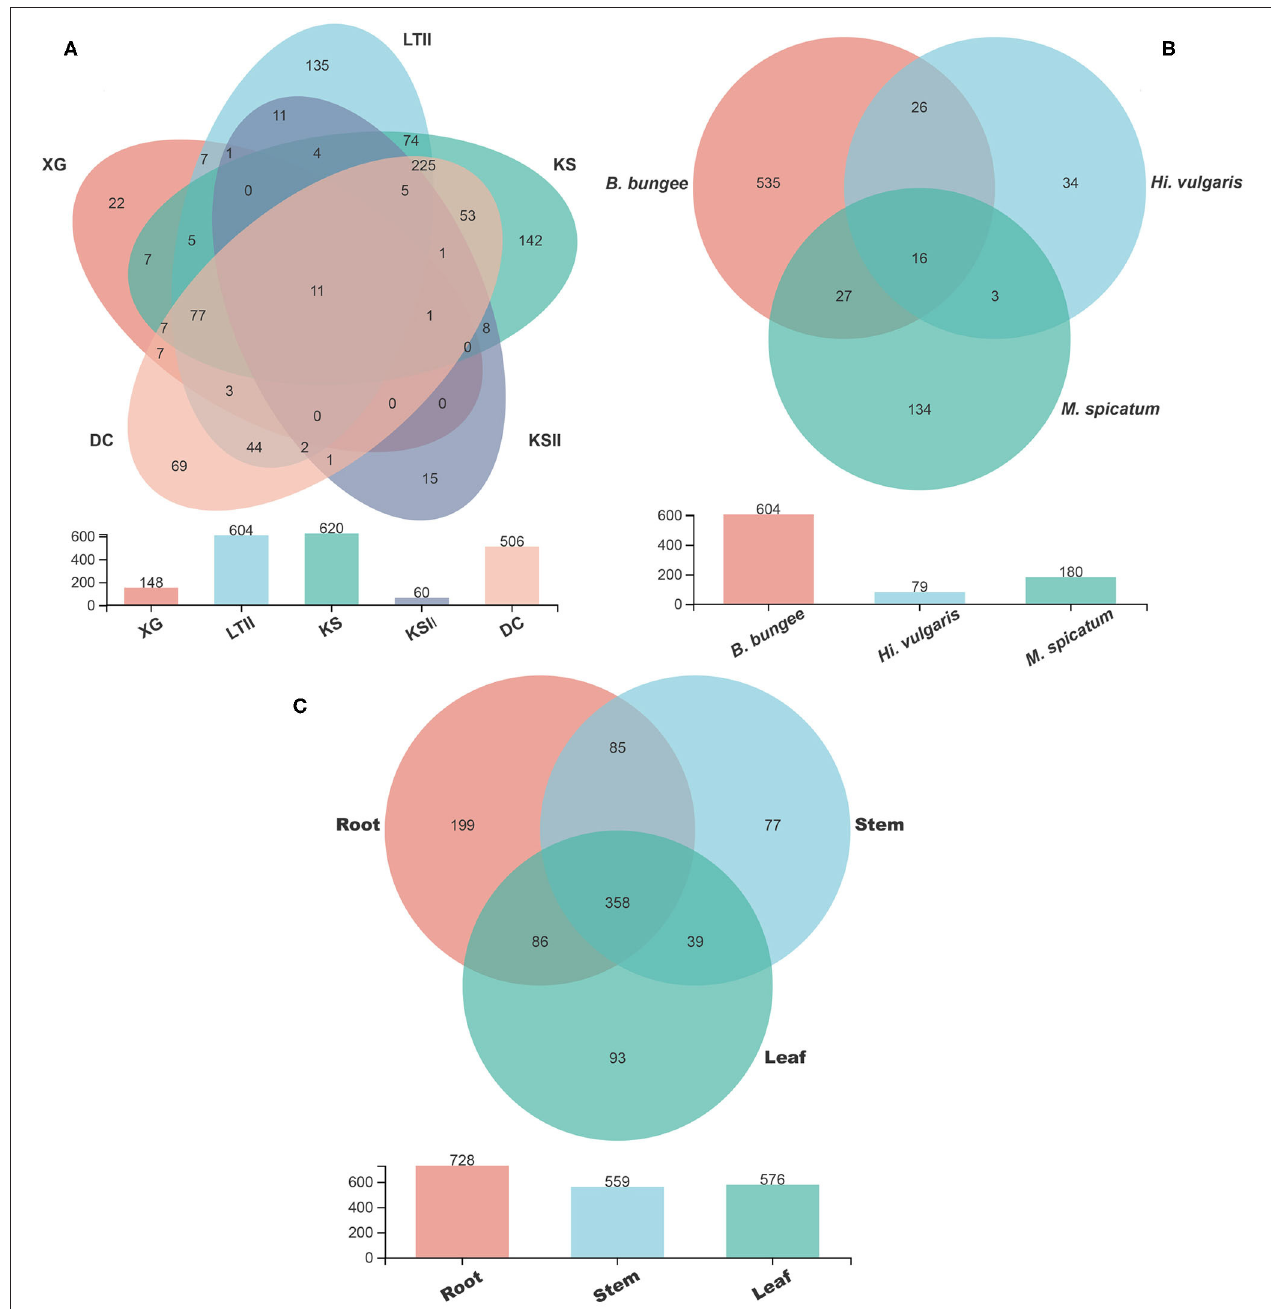
FIGURE 5 | Venn diagram showing the number of fungal OTUs detected in aquatic plants. (A) display the number of fungal OTUs of Batrachium bungei collected from five sampling sites; (B) display the number of fungal OTUs of three different aquatic plants collected from sampling site LTII; (C) displays the number of fungal OTUs of different tissues of B. bungei . Numbers in the overlapping region indicate shared OTUs between and among the groups. Numbers in the non-overlapping regions indicates unique OTUs for the